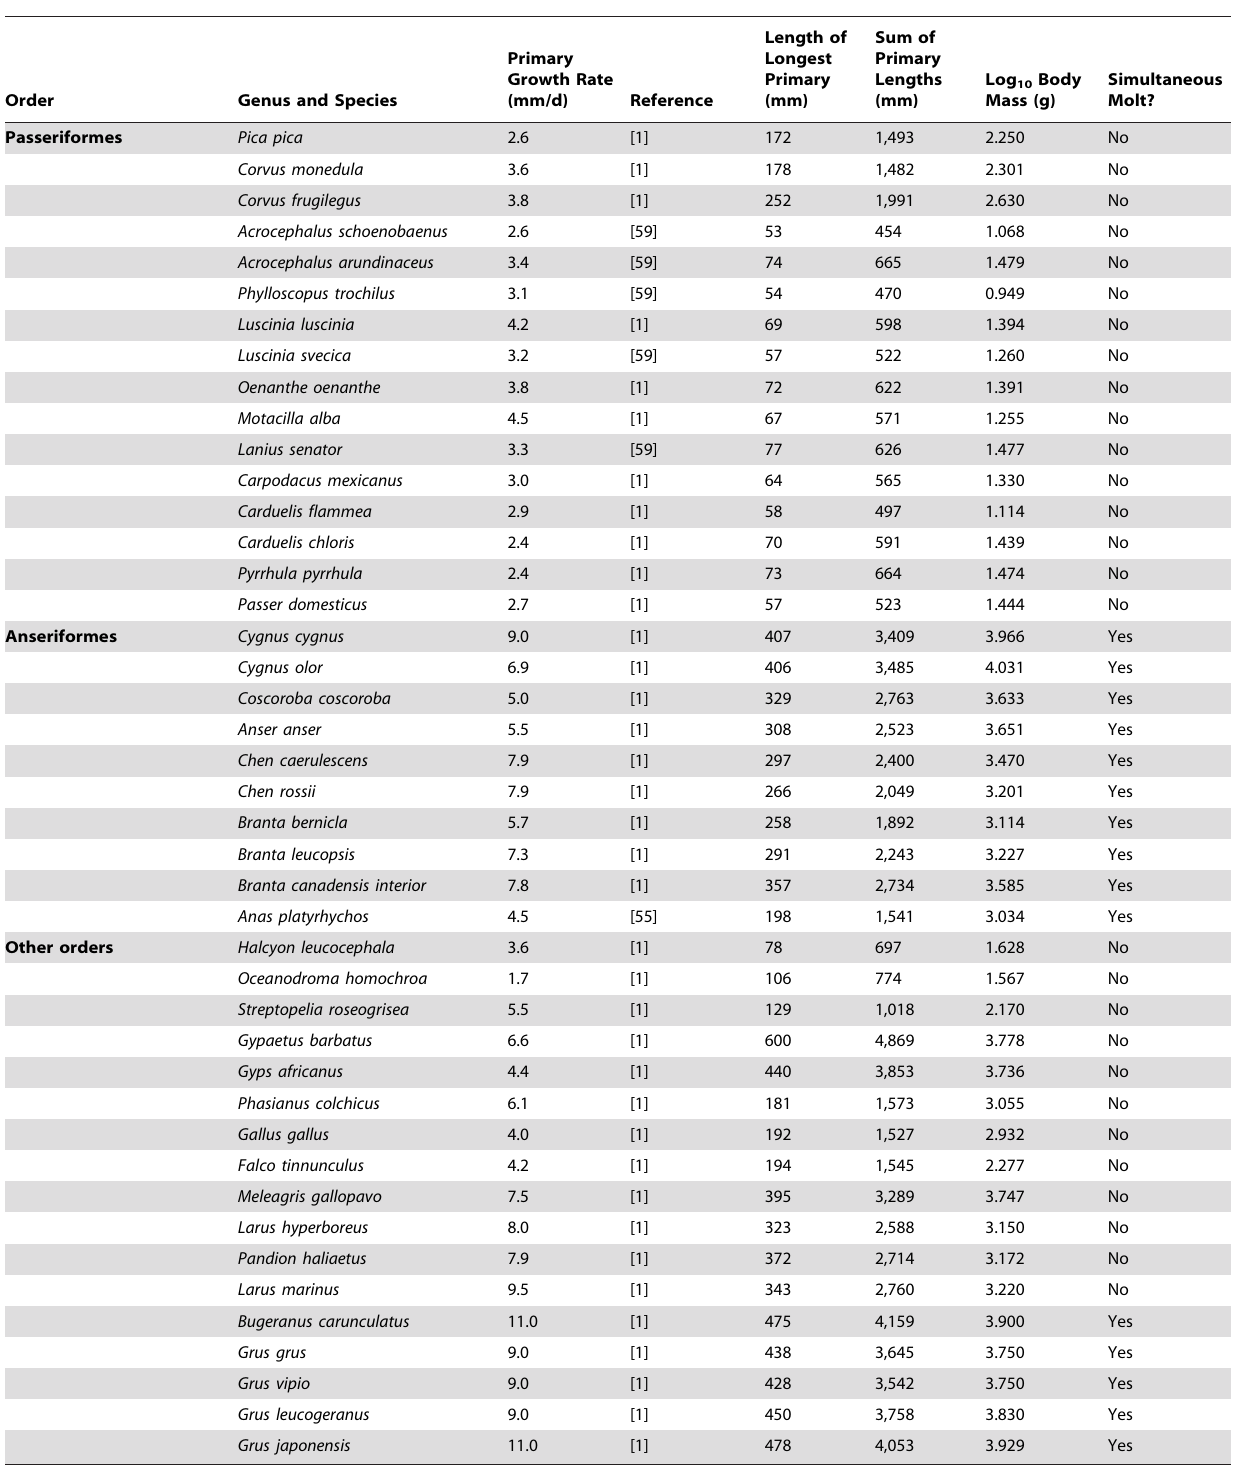
Table 1. Data used to generate the allometric equations of Figure 1A and 1B, and sources for the data on primary growth rate; primary lengths are from museum